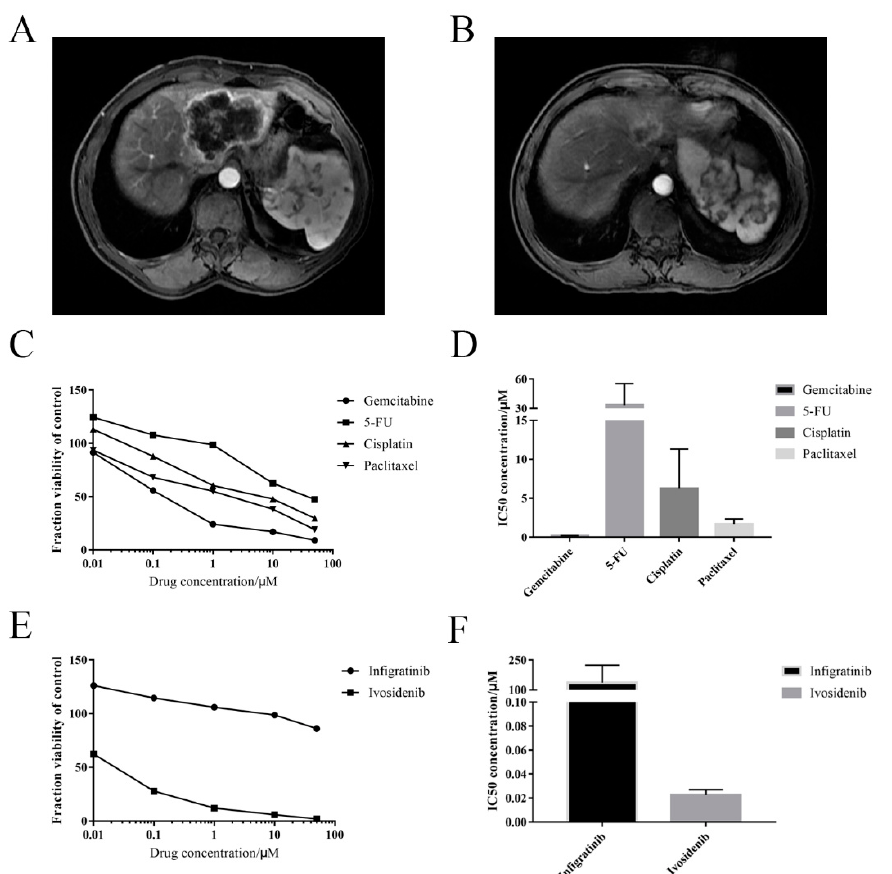
Figure 6. Drug screening of cancer organoid and validation of clinical case. ( A , B ) Magnetic resonance images of patient 8 at admission ( A ) and after receiving treatment of gemcitabine plus albumin-bound paclitaxel for three months ( B ). ( C – F ) Dose-response curves and half-maximal inhibitory concentrations (IC50) of the derived IHCC organoid treated with con- ventional chemotherapeutic drugs ( C , D ) and targeted drugs ( E , F ). Screening of each drug was performed in triplicate.